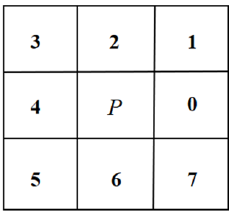
Table 1. Complementary relationship of eight-way chain code values.